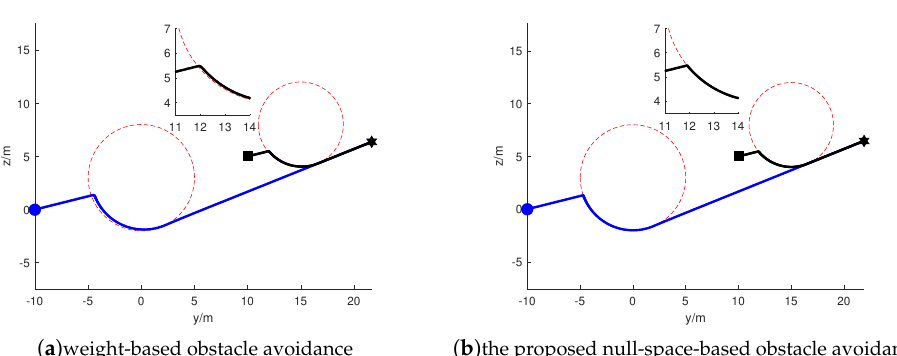
Figure 6. Comparison results in the longitudinal plane. The blue lines are pursuit trajectories, and the black lines are evasion trajectories. The red dashed circles represent obstacle zones that all players should avoid for